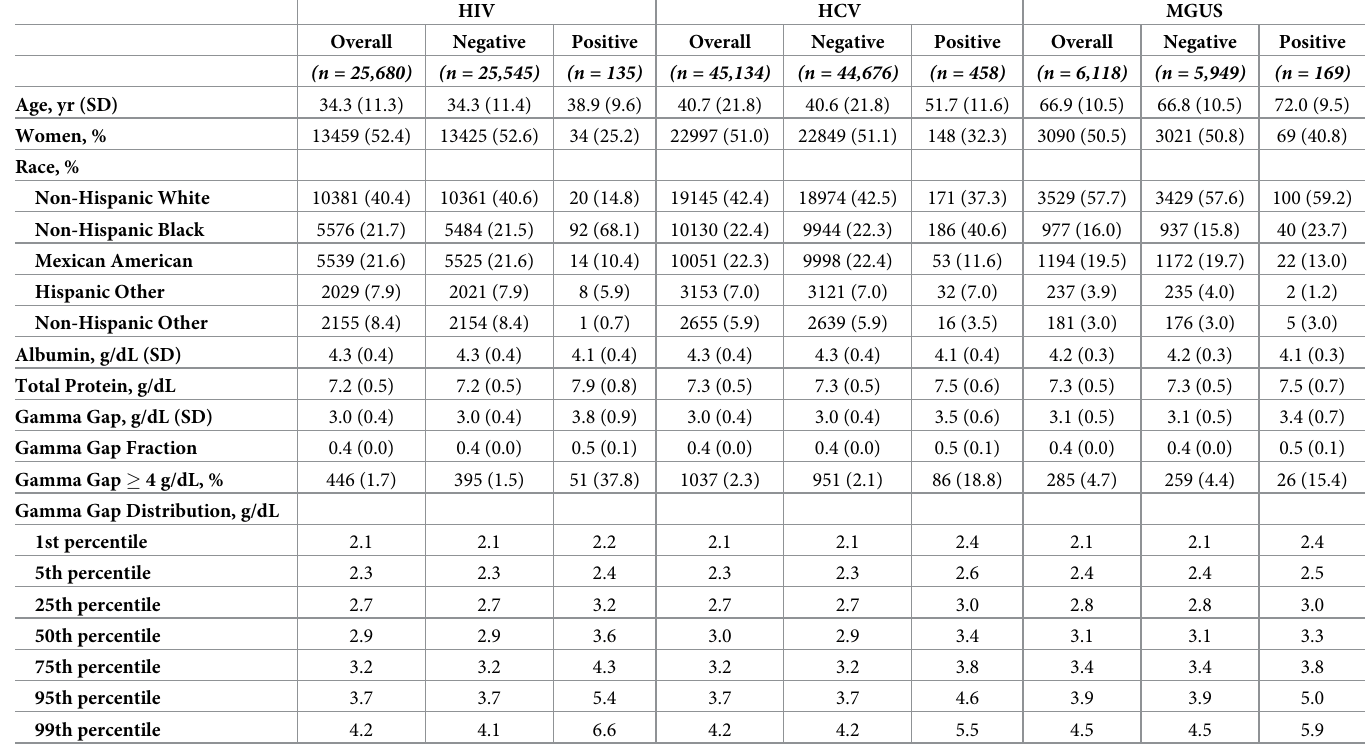
Table 1. Baseline characteristics.